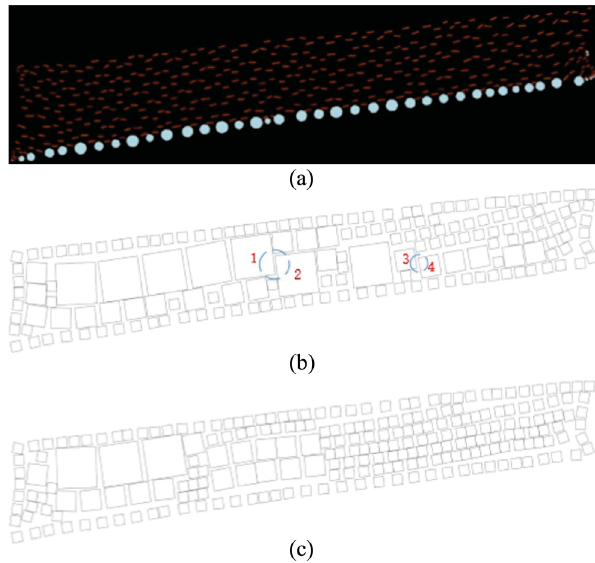
Fig. 3 Divide-and-conquer strategy. (a) Vector field. Red arrows: direction of the vector field. Blue circles: heat source points. (b) Result without divide-and-conquer strategy. (c) Result with divide- and-conquer